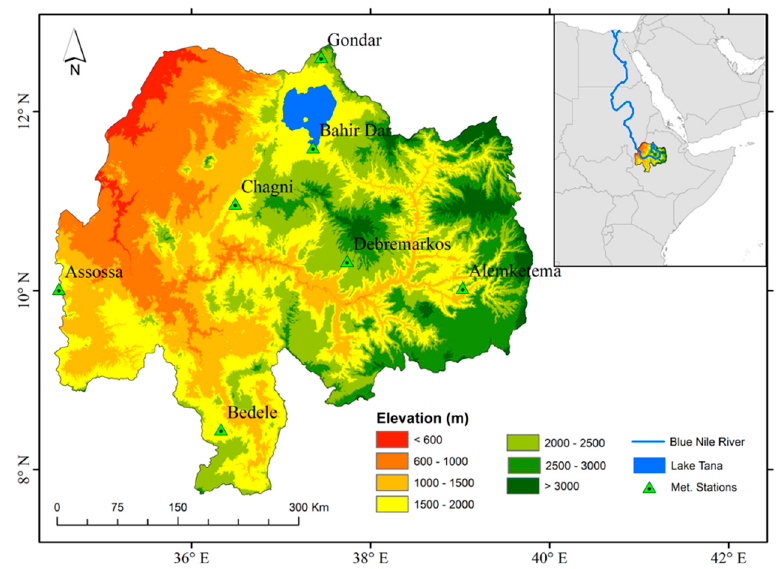
Figure 1. The geographical location of the Upper Blue Nile (UBN) river basin and metrological stations used in this study.